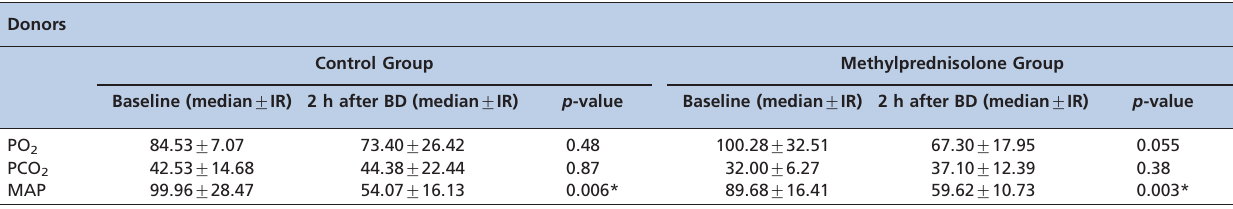
Table 1 - The level of arterial blood gases and the mean arterial pressure in donor rats before and 2 h following brain